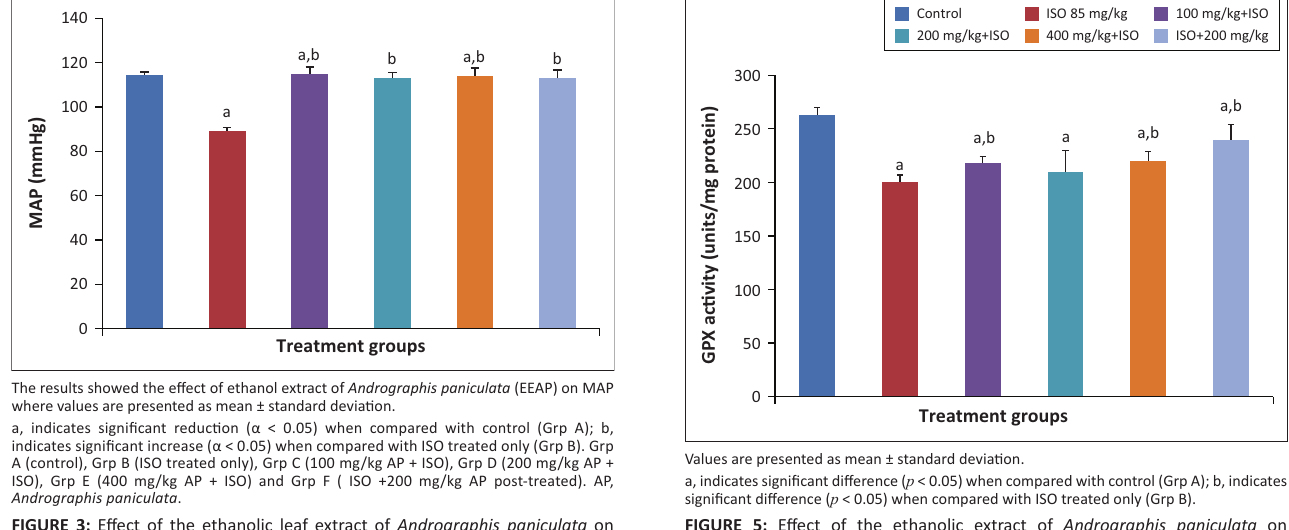
FIGURE 3: Effect of the ethanolic leaf extract of Andrographis paniculata on FIGURE 5: Effect of the ethanolic extract of Andrographis paniculata on mean arterial pressure (MAP) in isoproterenol-induced myocardial infarction glutathione peroxidase enzyme in isoproterenol-induced myocardial infarction using rats as a model. using rats as a model ( n = 5). TABLE 1: Effects of the ethanolic leaf extract of Andrographis paniculata on haemogram in isoproterenol-induced myocardial infarction using rats as a model. Groupings